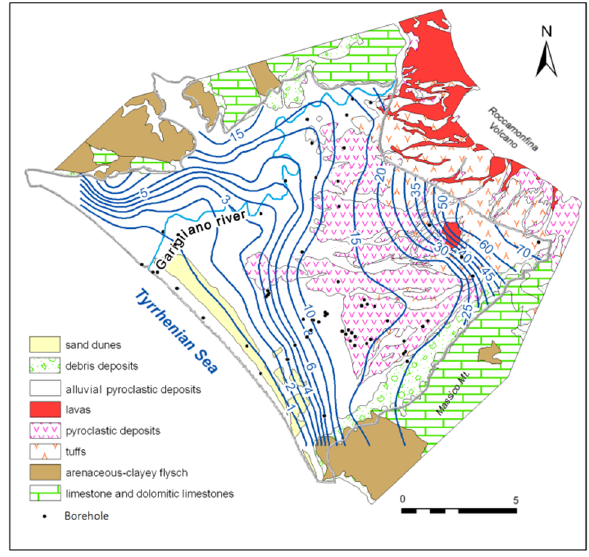
Figure 2. Hydrogeological map of the Garigliano River plain (modified from [22]).